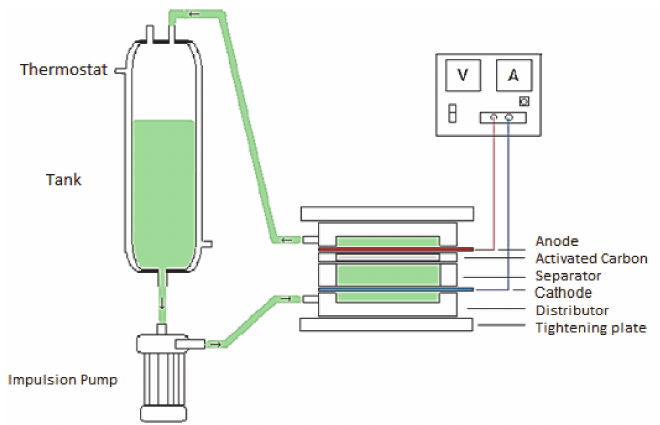
Figure 1. Schematic diagram of the electroadsorption experiments in which the electrochemical chemical cell together with the current source, water tank and impulsion pump are